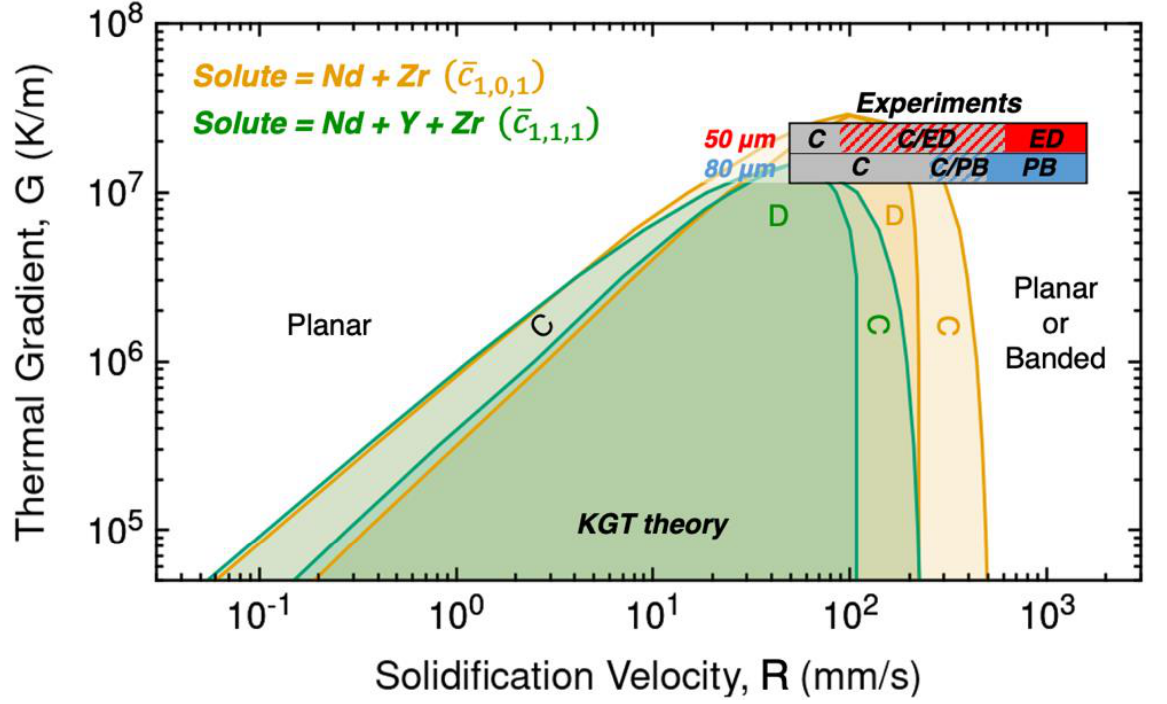
Figure 11. Computed WE43 solidification morphology map in G - R space, compared with experimental results (upper right). Results of KGT theory are presented for the two limiting cases of Y behavior (fully dispersed and nonmelted). The position of the experimental results along the G axis is a rough estimate and R is set to the scan velocity v . C = cellular, ED = equiaxed-dendritic, PB = planar-banded.